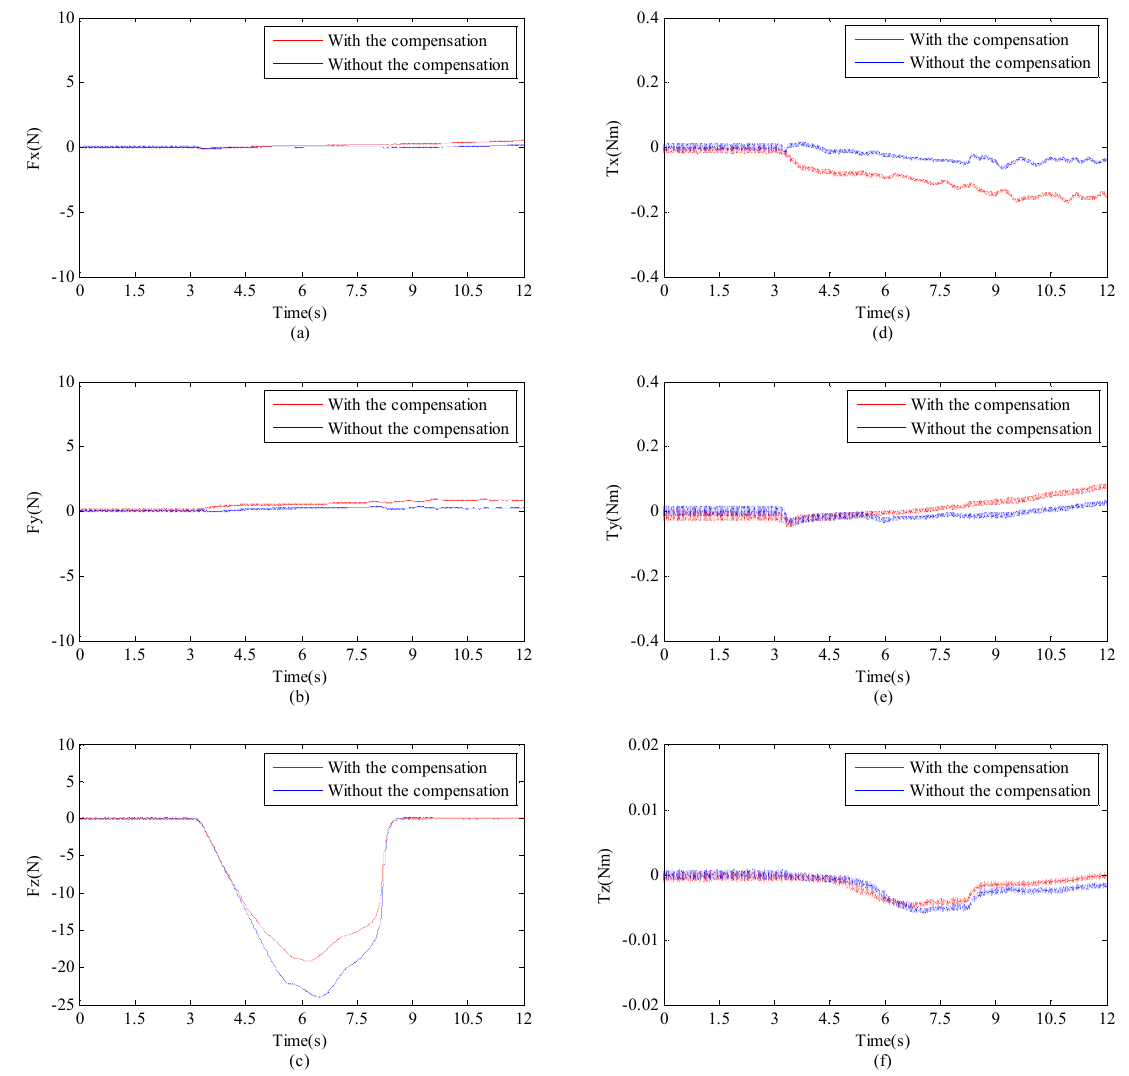
Figure 11. The forces and torques during the drilling operation of R2. ( a ) Fx is the force along x -axis; ( b ) Fy is the force along y -axis; ( c ) Fz is the force along z -axis; ( d ) Tx is the force around x -axis; ( e ) Fy is the force around y -axis; ( f ) Fz is the force around z -axis.